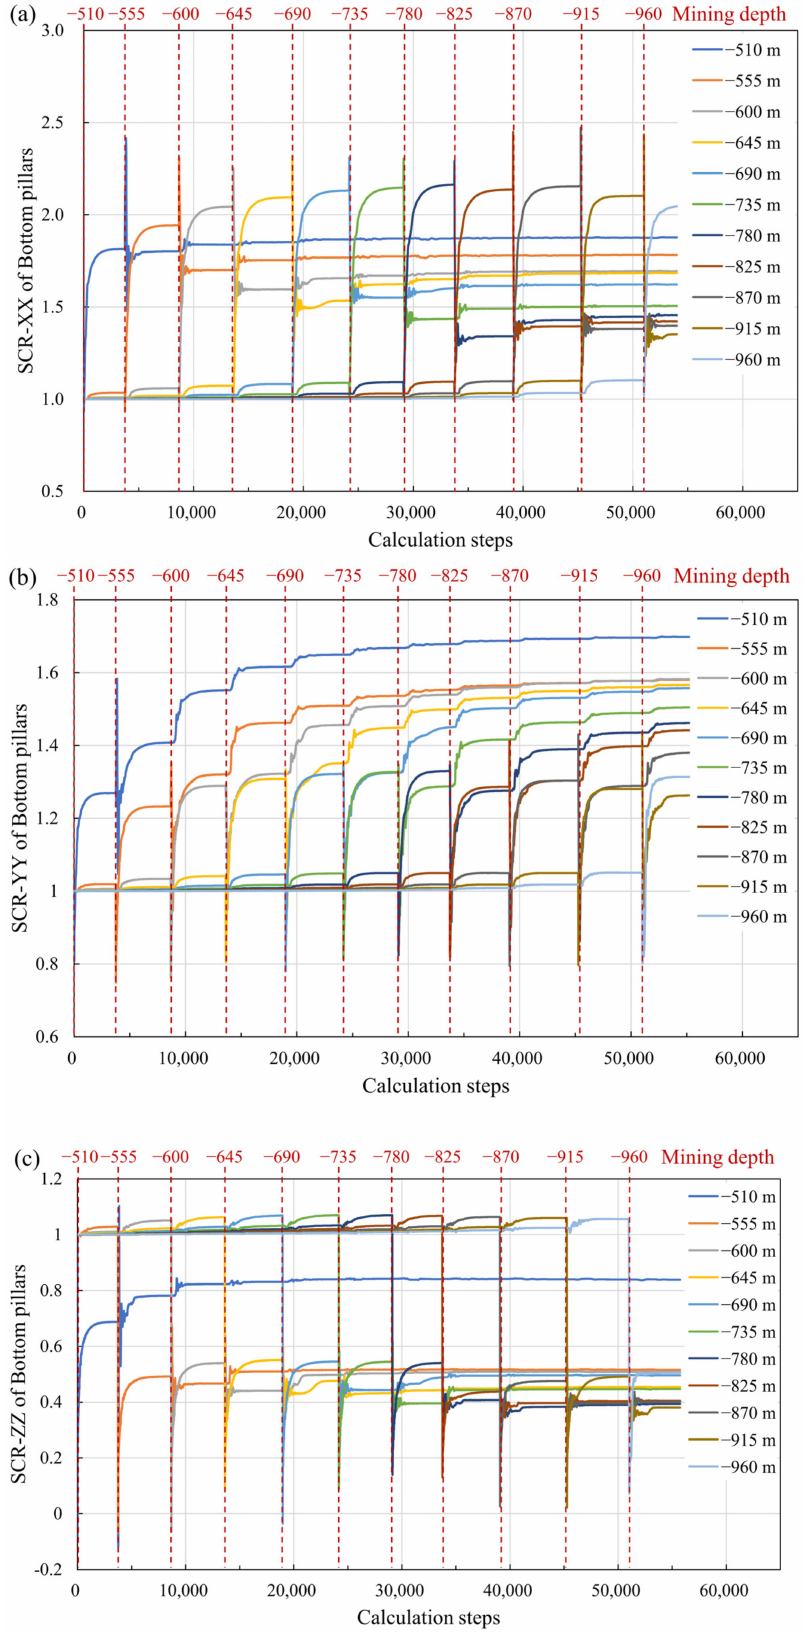
Figure 10. Variation regularity of stress ratio of bottom columns at various depths. ( a ) Stress ratio in XX direction, ( b ) Stress ratio in YY direction, and ( c ) Stress ratio in ZZ